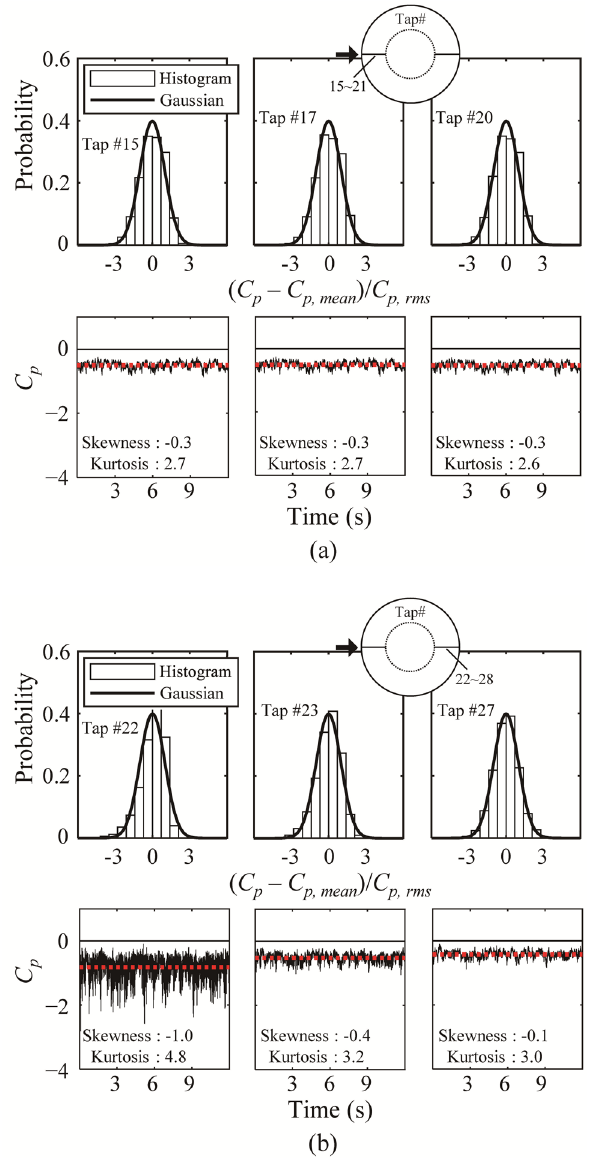
Figure 8. Histogram and time history of the pressure coefficient on internal roof surface: ( a ) windward and ( b ) leeward regions.